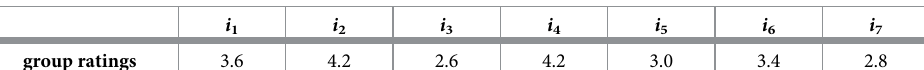
Table 11. Predicted group